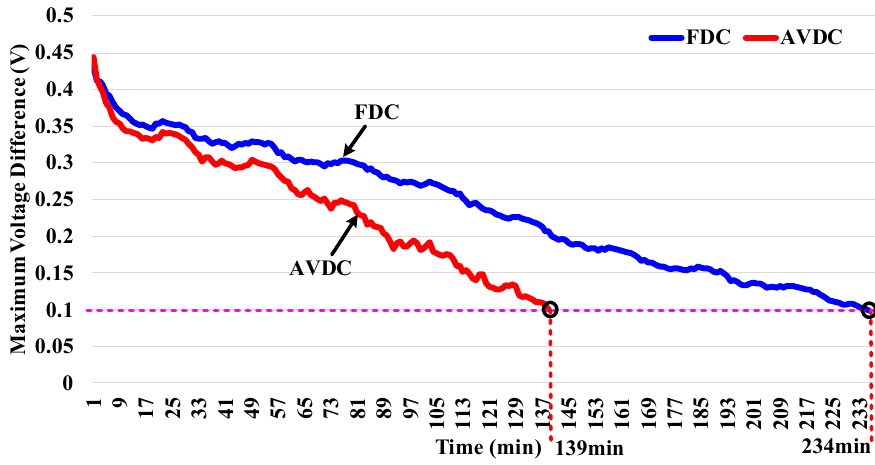
Figure 20. Curve of the Δ V diff ,max variation operated by the two methods.